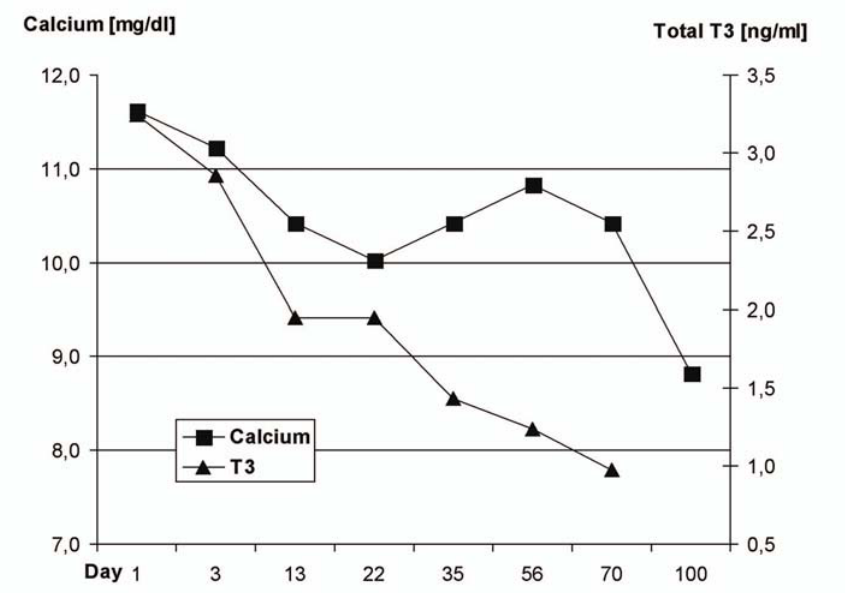
Fig. 1 Serum concentrations of calcium and thyroxine < (fT4). Thyrostatic treatment was initiated on day 1, and parathyroidectomy and near total thyroidectomy were per- formed on day